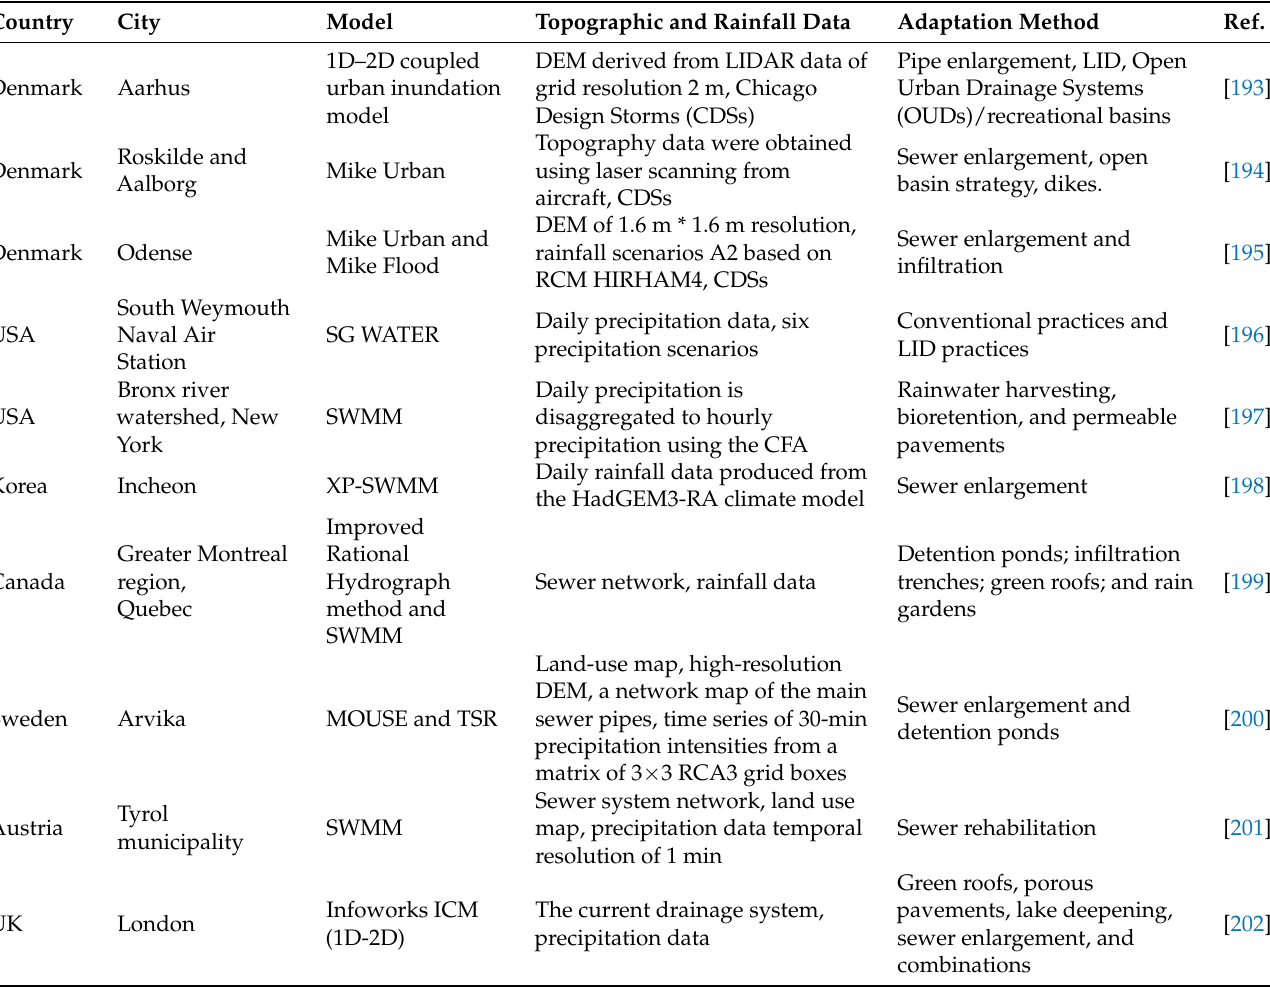
Table 4. Models, data used, and adaptation methods used in developed